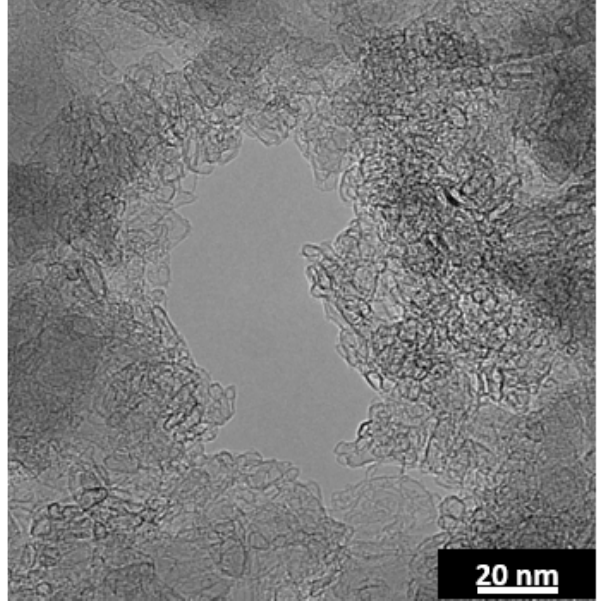
Figure 8. Soot formed from CO 2 laser vaporization of fluorene carbonization pitch.